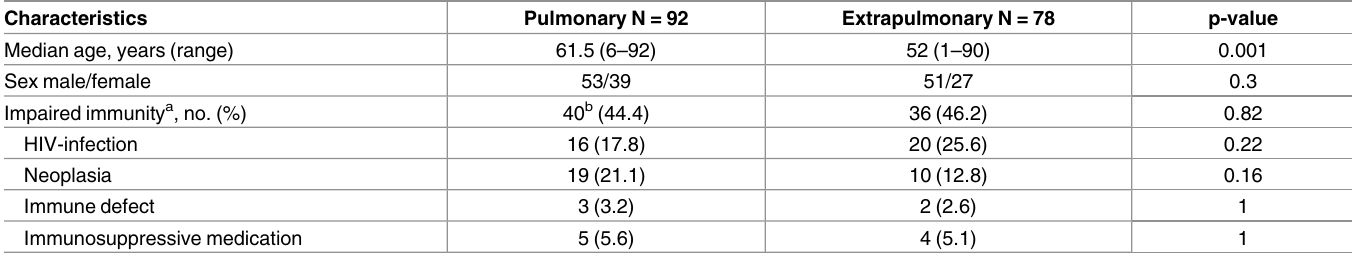
a Patients can belong to more than of these categories. b Data were not availablefor two patients.